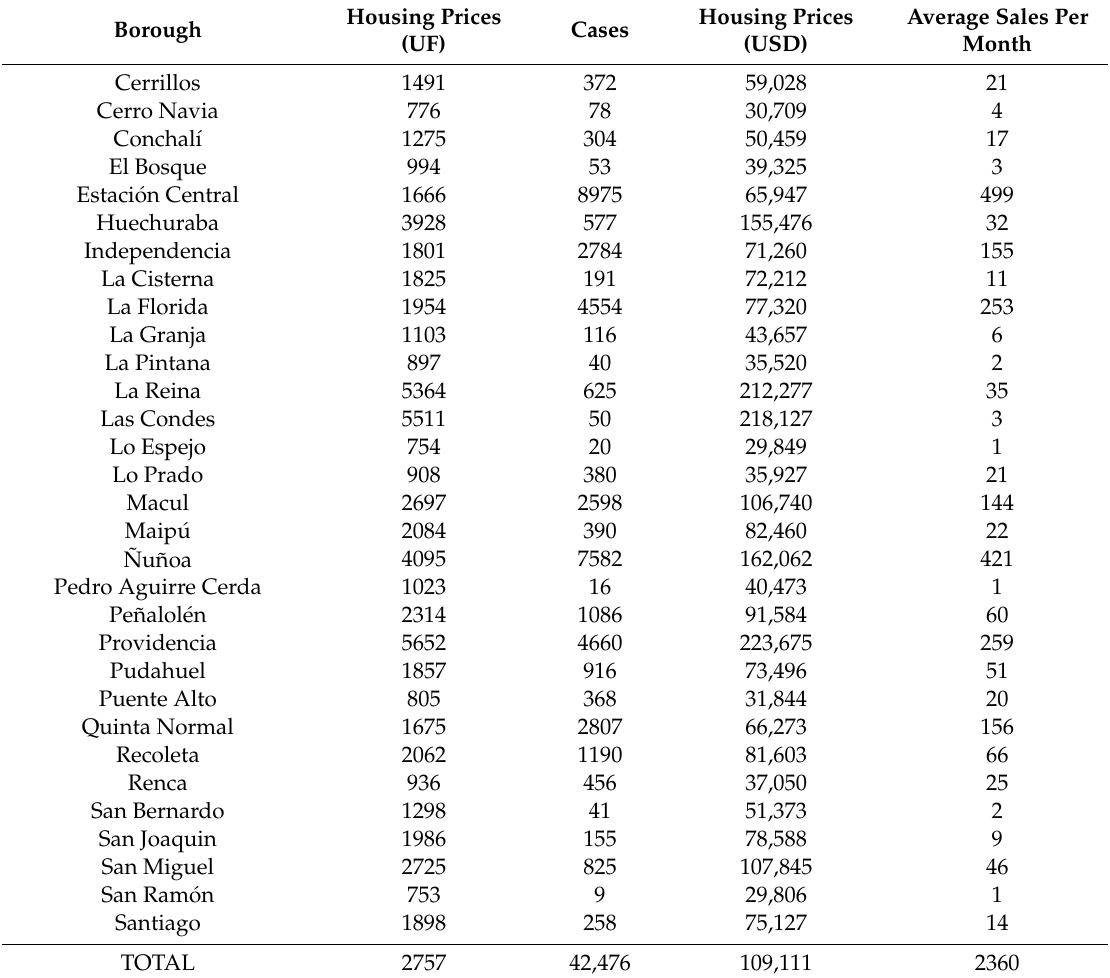
Table 1. The housing prices for housing units in high-rise buildings for 2018–2019. Source: Prepared and calculated by authors based on data obtained from InCiti.com